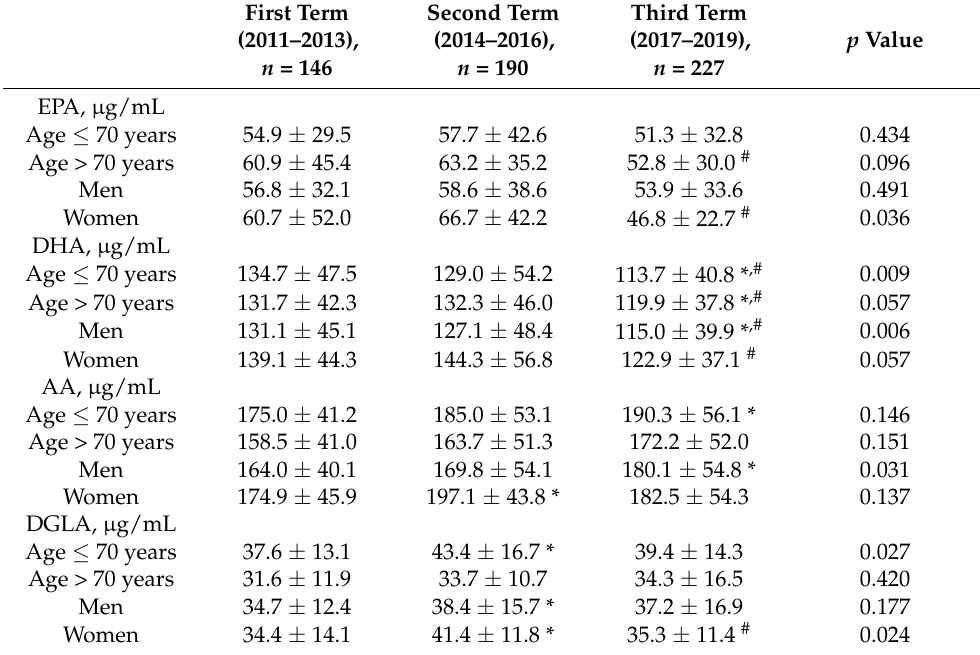
Table 4. Secular trend in polyunsaturated fatty acids in patients without